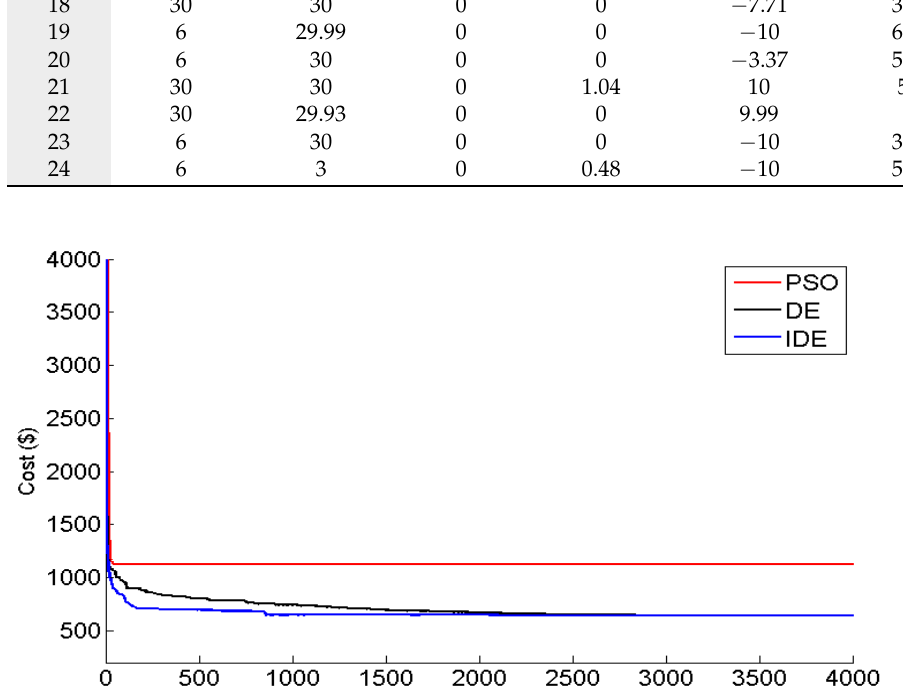
Figure 2. Cost convergence diagram in different methods without considering the limitations of power exchange with upstream network.